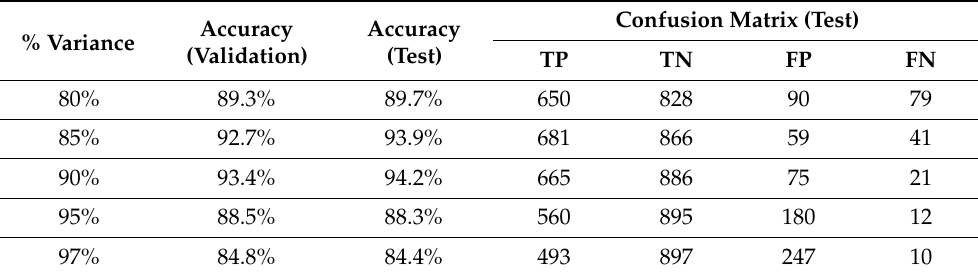
Table 6. Results of the SVM classifier for different PCA variance after 10-fold cross-validation. %